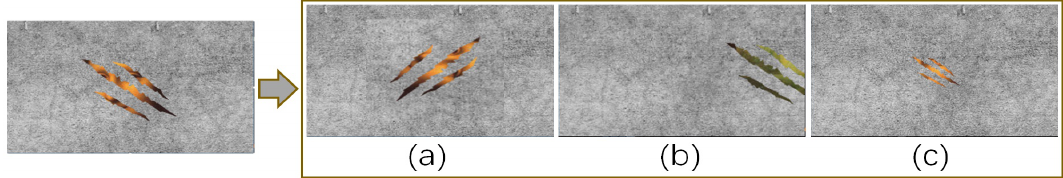
Figure 8. Erasure animations with different rotation angles, different positions, different amplitudes, and different times of shaking actions.